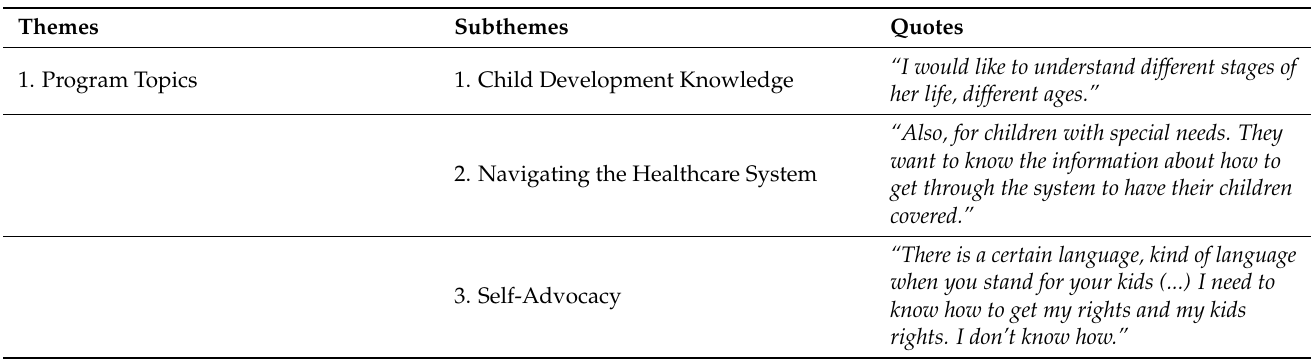
Table 2. Summary of